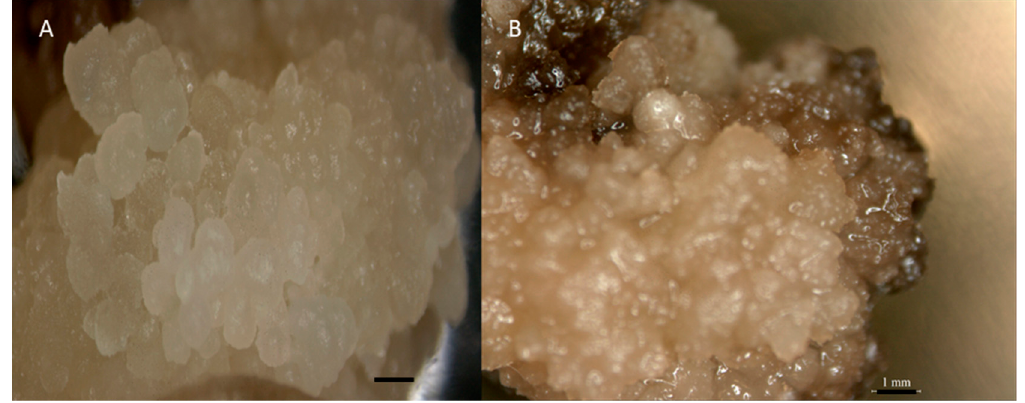
Figure 5. Callus morphology of 30 g/L Maltose ( A ) and sucrose (B) on MS media supplemented with 3 mg/L 2,4-D. Bar = 1 mm.